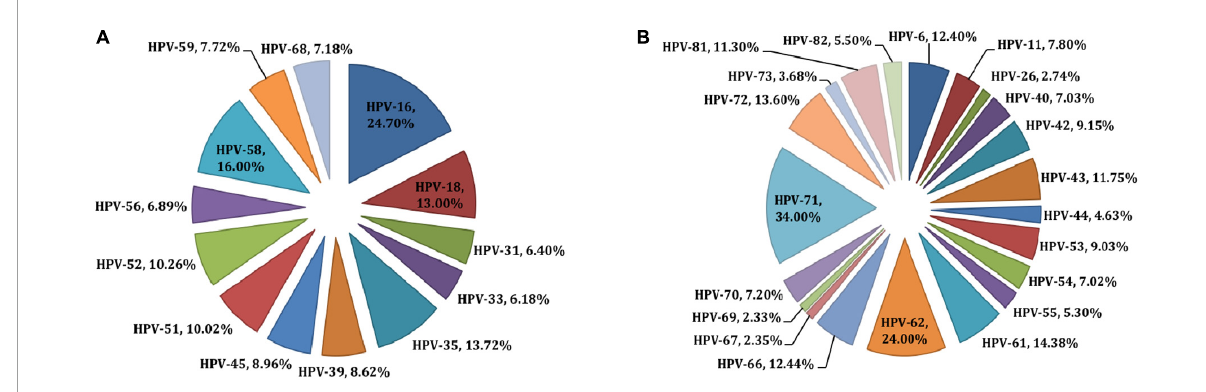
FIGURE1 Prevalences of high-risk (A) and low-risk (B) HPV types in Botswana. All HPV types detected in individuals are reported; therefore, prevalences across all types sum to 100%.